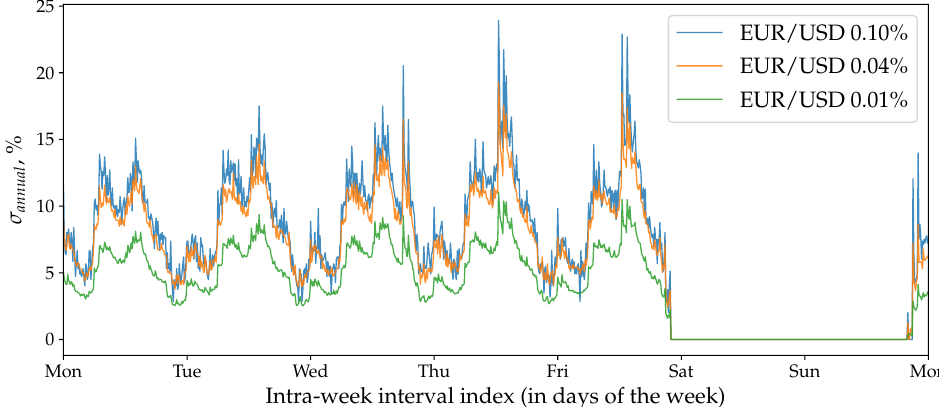
Figure 10. Volatility seasonality of EUR/USD computed using the novel approach (Equation (19)) and three different thresholds: δ = 0.01%,0.04%,0.10% . The size of a bin is 10 min, there are 1008 bins { }